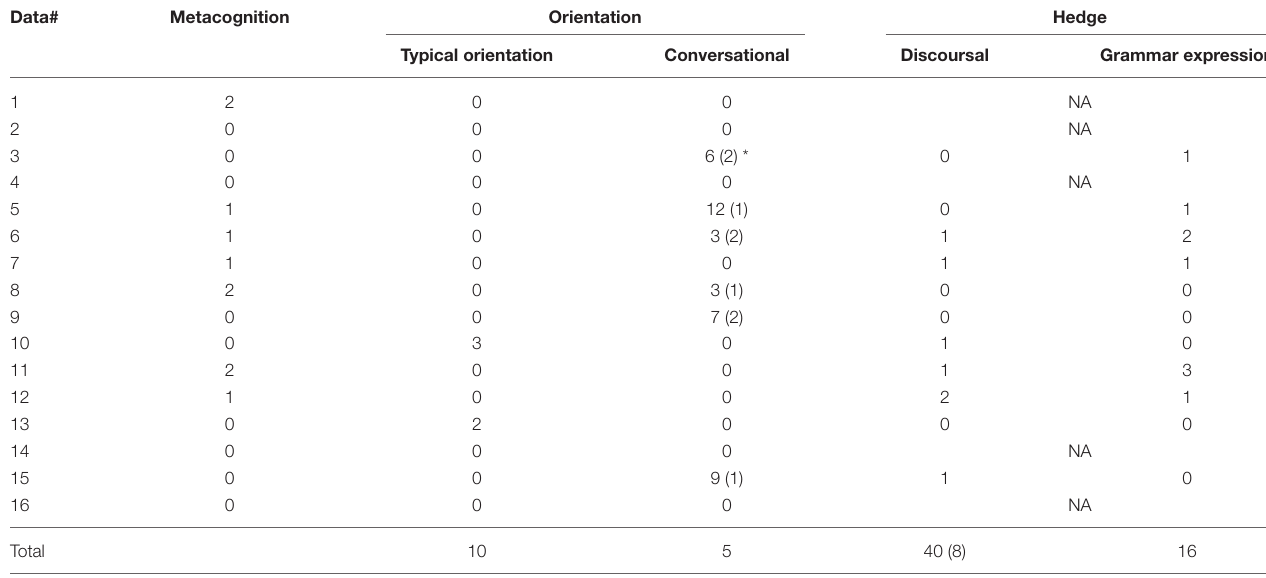
TABLE 5 | Occurrence of each type of cognitive test. Data# Metacognition Orientation Hedge Typical orientation Conversational Discoursal Grammar